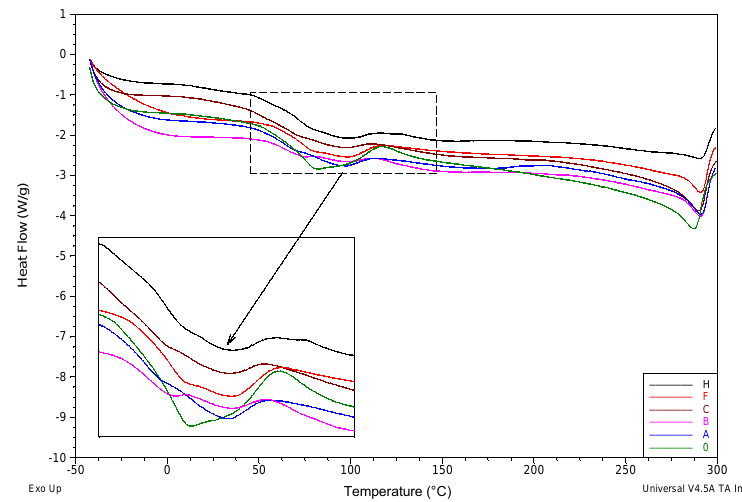
16 of 19 Figure 11. DSC curves for samples of unmodified PAN membrane (0) registered in the heating mode in nitrogen atmosphere with the rate of: 10°/min (green) and 60°/min (blue), respectively. The thermal effects mentioned in Figure 11 (marked on the curve marked with red arrows as T g 1 and T g 2 , respectively) are of a relaxing nature, and their occurrence is directly related to the transition from the thermodynamic glassy to viscoelastic state, within the amorphous PAN phase